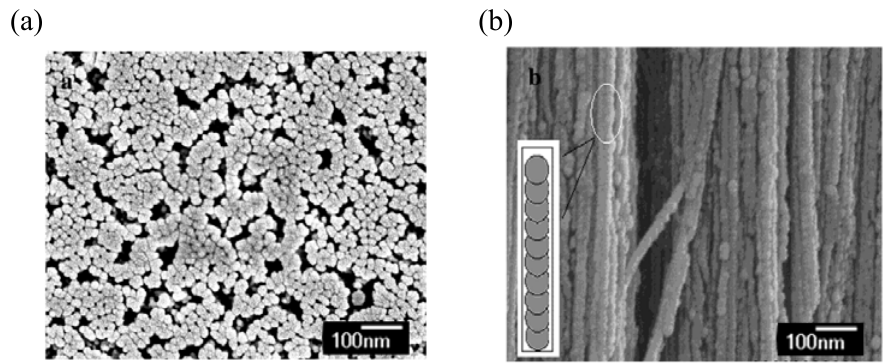
•[Ni(dmit) ] nanowire arrays after 4 2 2